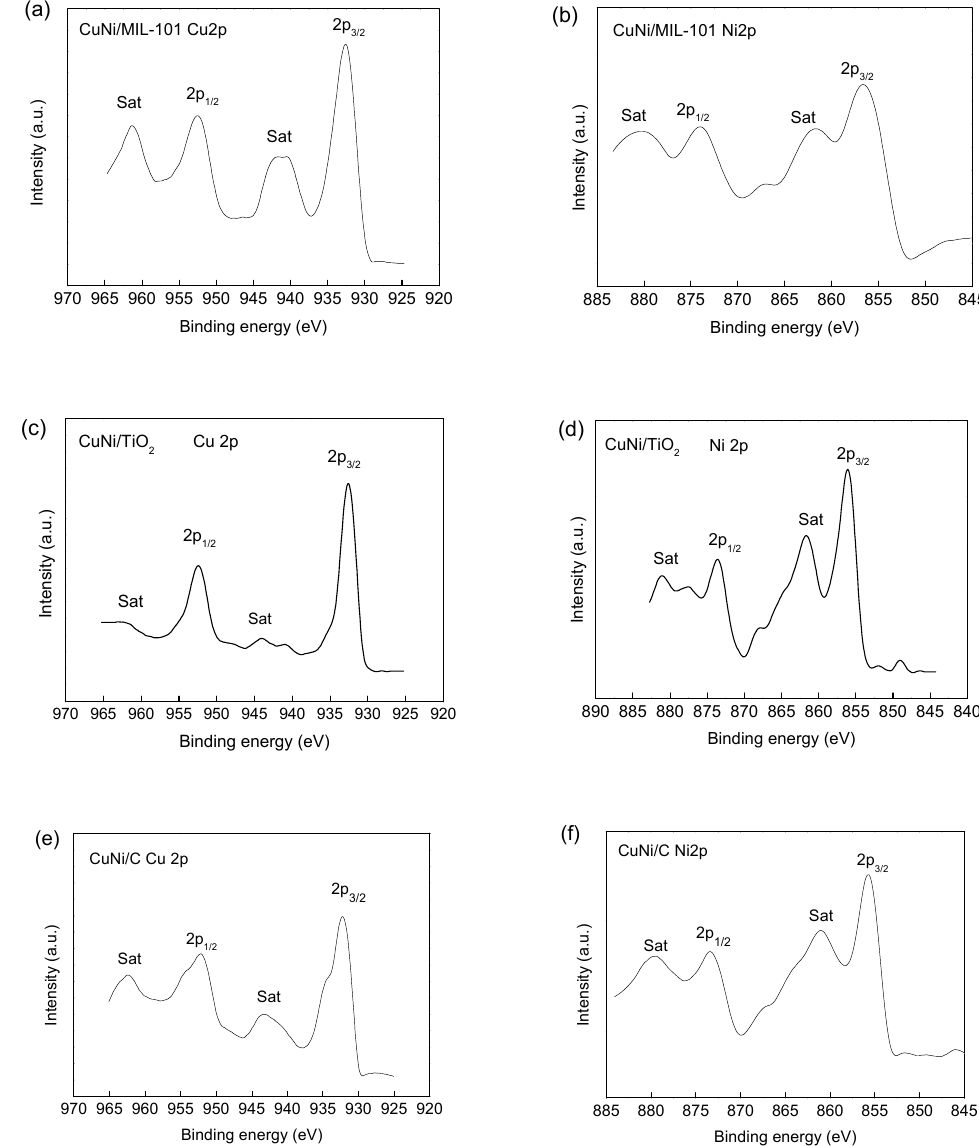
Figure 4. XPS spectra of CuNi/MIL-101 ( a , b ), CuNi/TiO 2 ( c , d ), and CuNi/C ( e , f ).